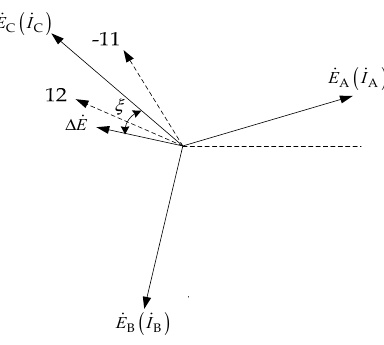
Figure10. Phasor diagram when motor rotates counterclockwise. Figure 10. Phasor diagram when motor rotates